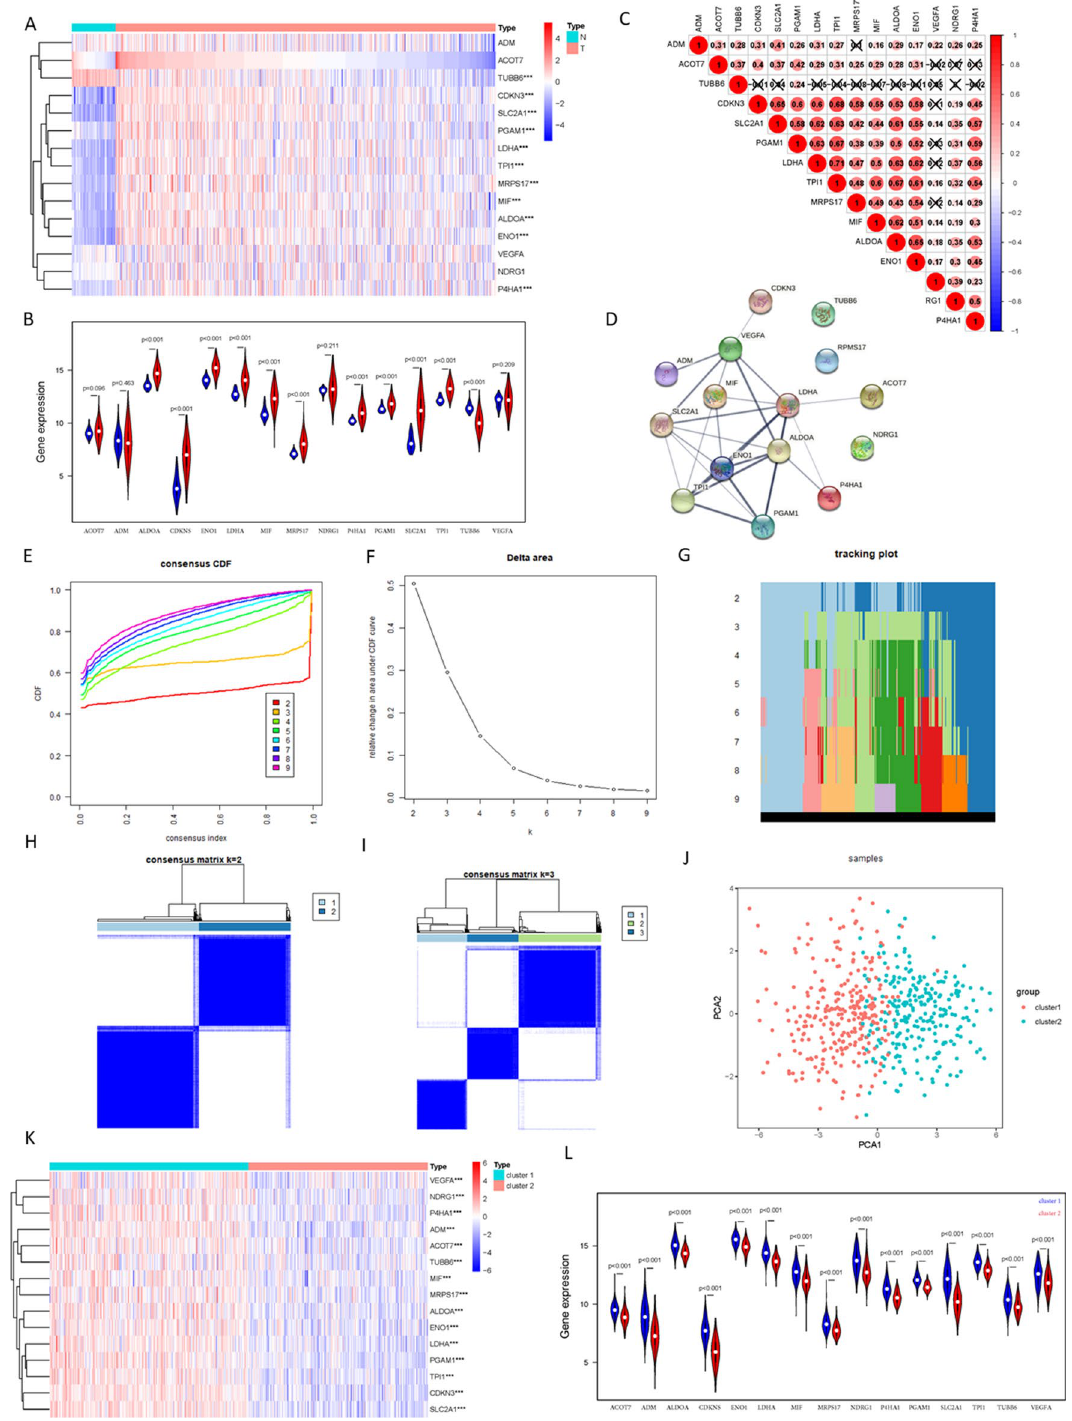
Figure 2. Consensus Clustering identified two clusters of LUAD with different hypoxia status. ( A , B ) The heatmap and violin plot of the 15 hypoxia related gene expression signature in TCGA-LUAD tumor and normal samples (Wilcox Test). ( C ) Spearman correlation analysis of the 15 hypoxia related gene expression signature. ( D ) The PPI network of the 15 hypoxia related gene expression signature. ( E ) The CDF value of consensus index. ( F ) Relative change in area under CDF curve for k = 2–9. ( G ) The tracking plot for k = 2 to k = 9. ( H , I ) Consensus matrix for k = 2 and k = 3. ( J ) Principal component analysis of the total RNA expression profile. (K-L) The heatmap and violin plot of the 15 hypoxia related gene expression signature in cluster1 and cluster2 (Wilcox Test). *P < 0.05, **P < 0.01, and ***P <